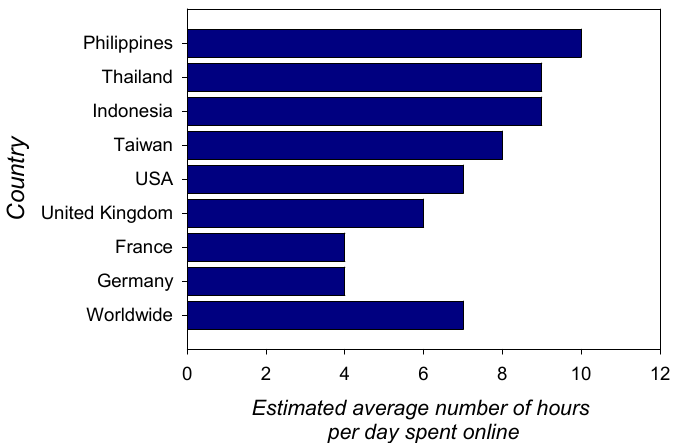
Figure 2. Estimated average time (number of hours per day) spent online by individuals between 16 and 64 years of age [27]. Times vary, as shown here, between countries. The average time spent online is currently estimated to seven hours per day worldwide and is expected to increase further. In the USA in 2017, this number was estimated to amount to two hours and 20 minutes per day for children between zero and two years of age and four hours and 30 minutes for kids between eight and 12 years of age [28,29].